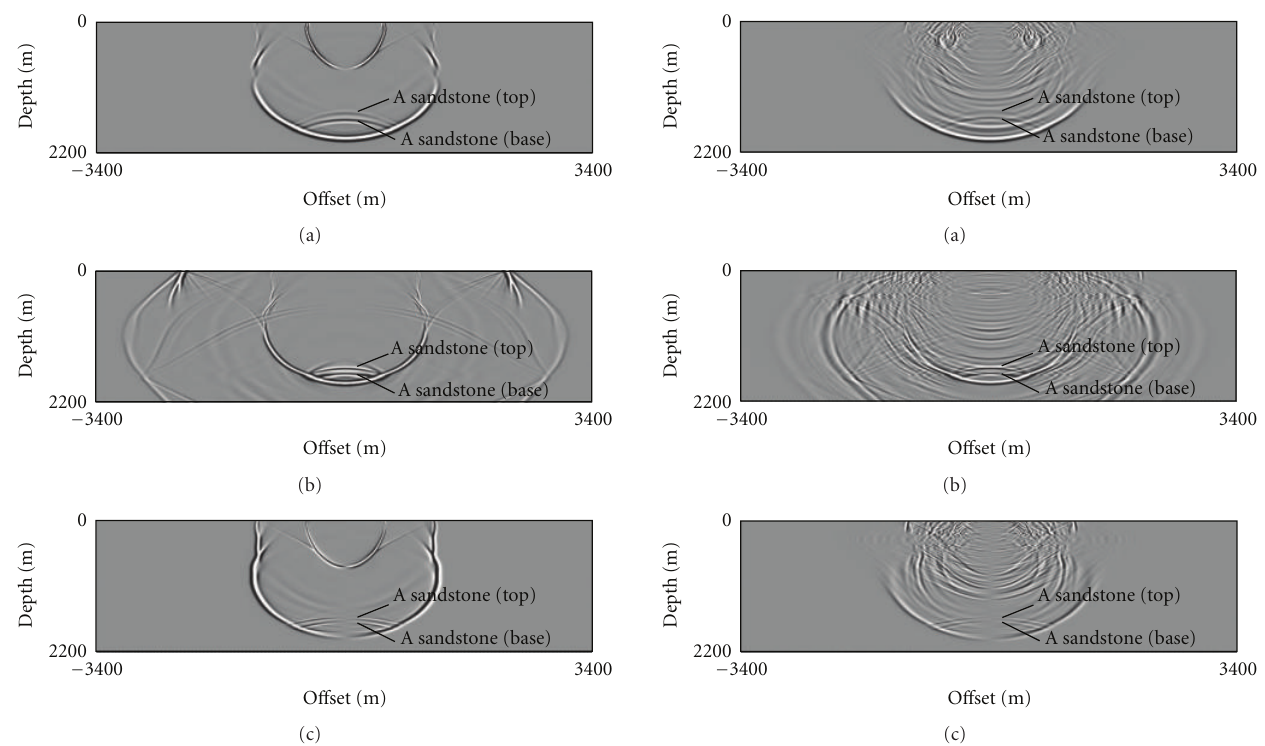
Figure 7: Wave propagation snapshots for (a) P-wave, (b) S-wave and (c) PS-wave using Model 1a. We observe that S-wave shows a stronger Morrow A sandstone response as compared to P- and PS- wave.